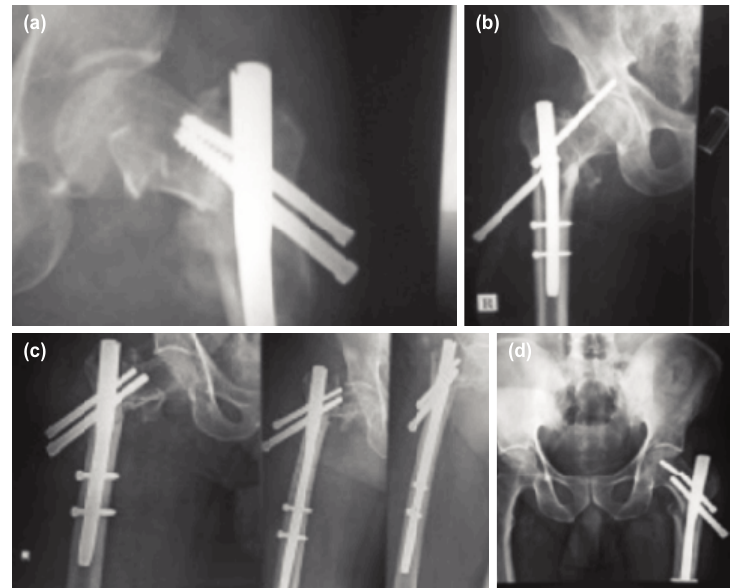
(a) Complication - loss of reduction with screw back out; no breakage. (b) Complication - ‘Z effect’. (c) Complication - screw back Fig. 4: out in primary modified short PFN (left) as well as re-do with standard PFN in the same patient. (d) Complication - Screw cut- out and breakage with loss of reduction.